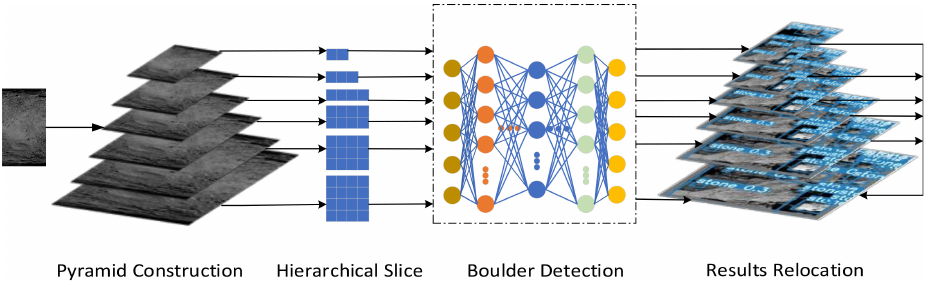
Figure 4. The framework of the pyramid based